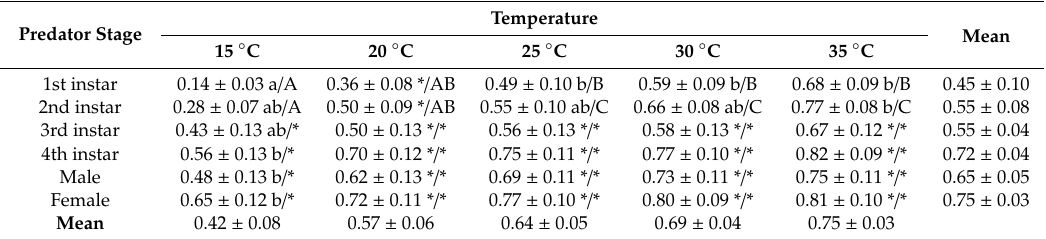
Table 2. Proportionate prey consumption ( ± SE) rate on Spodoptera litura eggs by Harmonia axyridis at various predatory stages and temperatures.